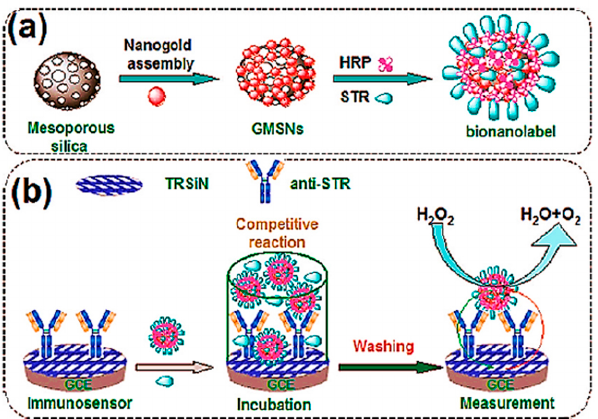
Figure 8. ( a ) Schematic illustration of the bionanolabel construction process and ( b ) fabrication process of the STR immunosensor and principle of the competitive assay (reproduced from Liu et al. [87] with permission from American Chemical Society).